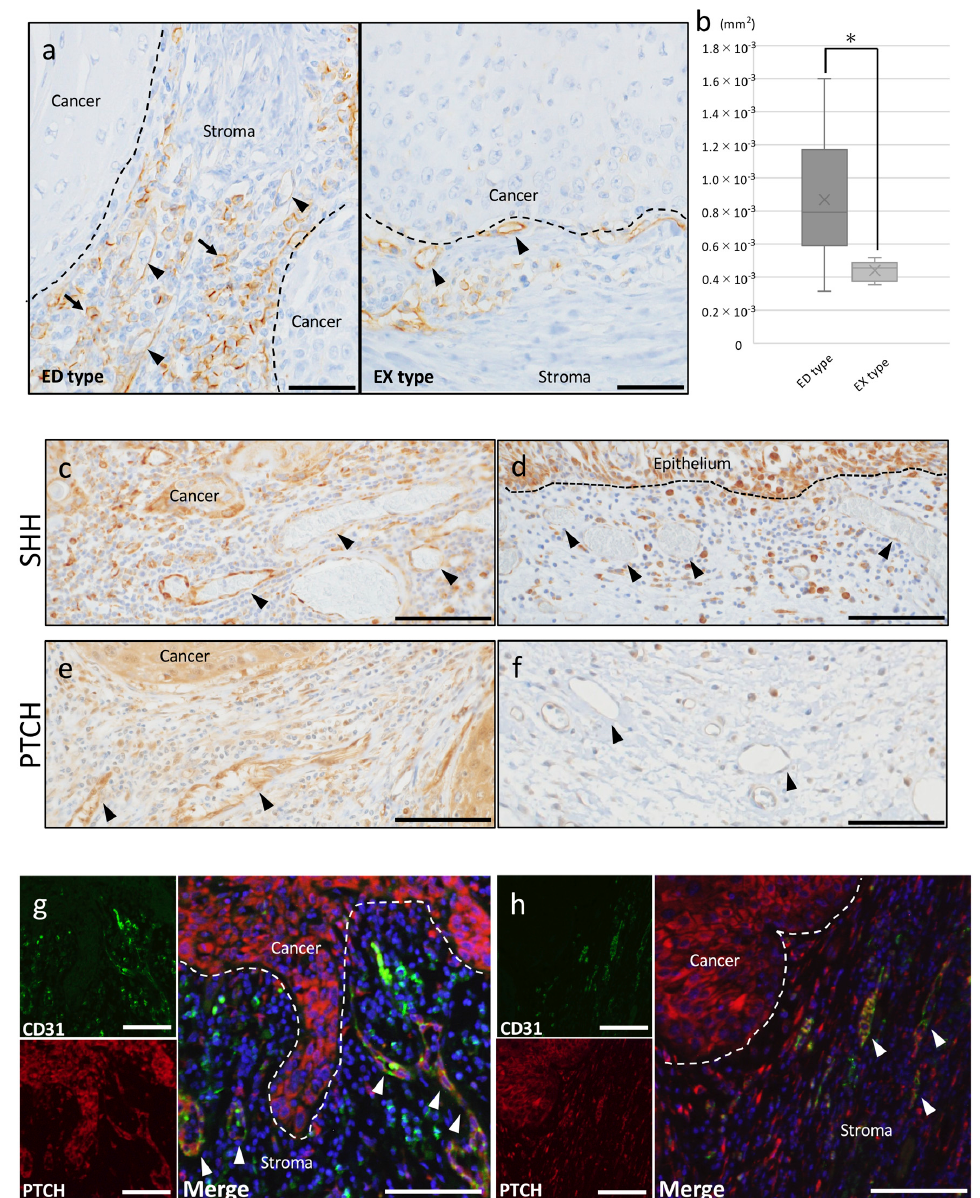
Figure 2. IHC and immunofluorescence of CD31. ( a ) IHC staining for CD31 in ED type and EX type. CD31 positive expression was observed in blood vessels (arrowheads). CD31 positive round-shape cells were observed (arrows). Scale bar: 50 μ m. ( b ) Quantification of the angiogenesis area in ED type and EX type. ED type showed superior angiogenesis compared to EX type. * p < 0.05 as indicated. ( c ) IHC feature of SHH in ED-type stroma. The accumulation of these blood vessels (arrowheads) was shown adjacent to the site where the SHH was strongly expressed in the cancer parenchyma. Scale bar: 100 µ m. ( d ) IHC feature of SHH in non-cancerous area. The connective tissue adjacent to normal epithelial tissue had few blood vessels that expressed SHH weekly (arrowheads). Scale bar: 100 µ m. ( e ) IHC feature of PTCH in ED-type stroma. The PTCH positive blood vessels (arrowheads) was shown adjacent to the cancer parenchyma. Scale bar: 100 µ m. ( f ) IHC feature of PTCH in non-cancerous area. The PTCH positive blood vessels were not observed (arrowheads). Scale bar: 100 µ m. ( g , h ) Double-fluorescent IHC in ED type and EX type. Double-fluorescent IHC for PTCH-CD31 demonstrated that both PTCH and CD31 were positive in blood vessels (arrowheads) in the cancer stroma in ED type and EX type. Scale bar: 100 µ